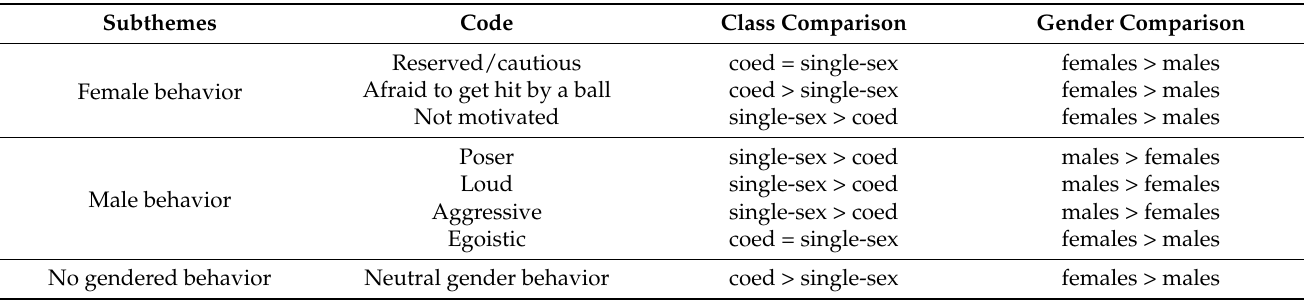
Table 2. Descriptions of stereotypical behavior in PE attributed to either the female gender, male gender or no